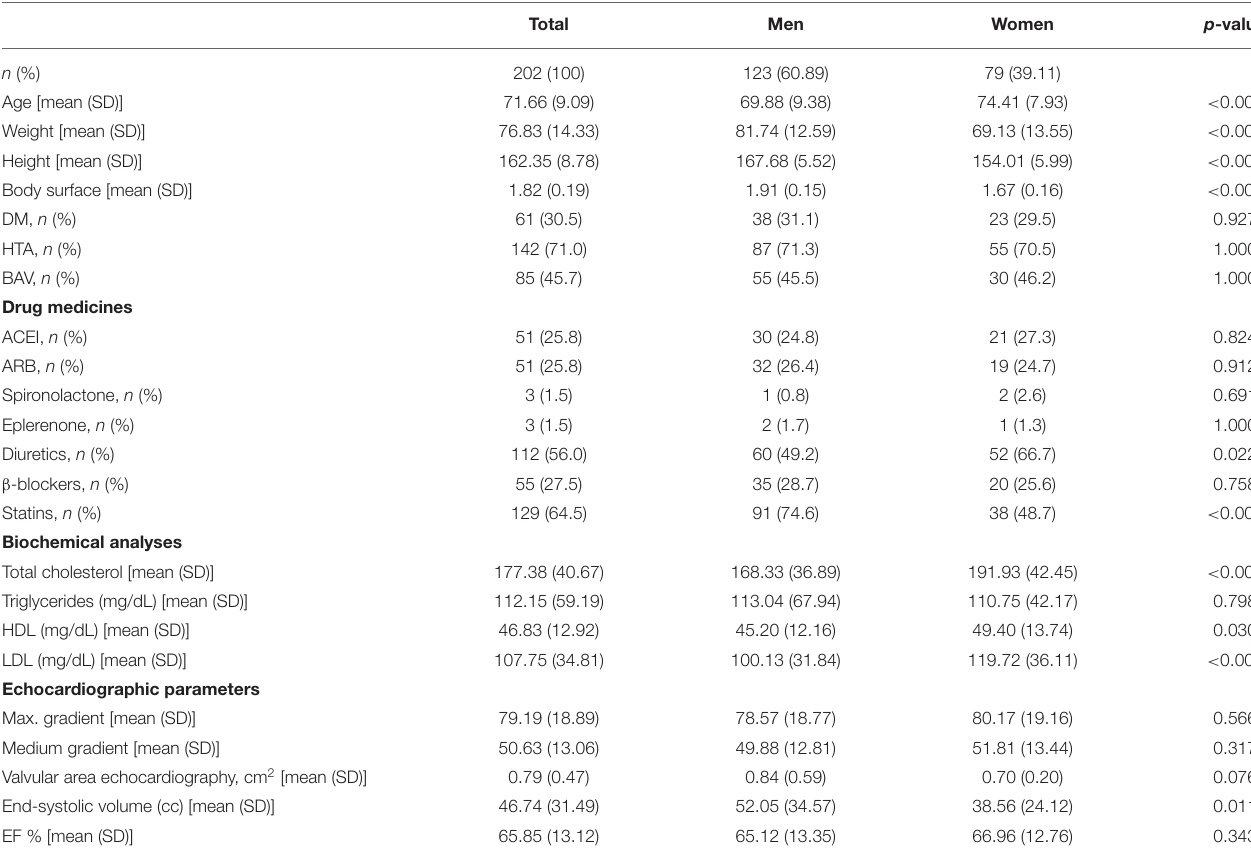
TABLE 1 | Demographical and clinical data of aortic stenosis patients. Total Men Women p